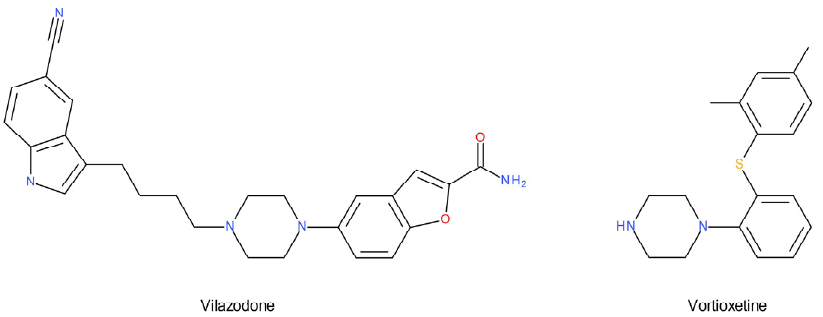
Figure 1. Novel antidepressants: vilazodone and